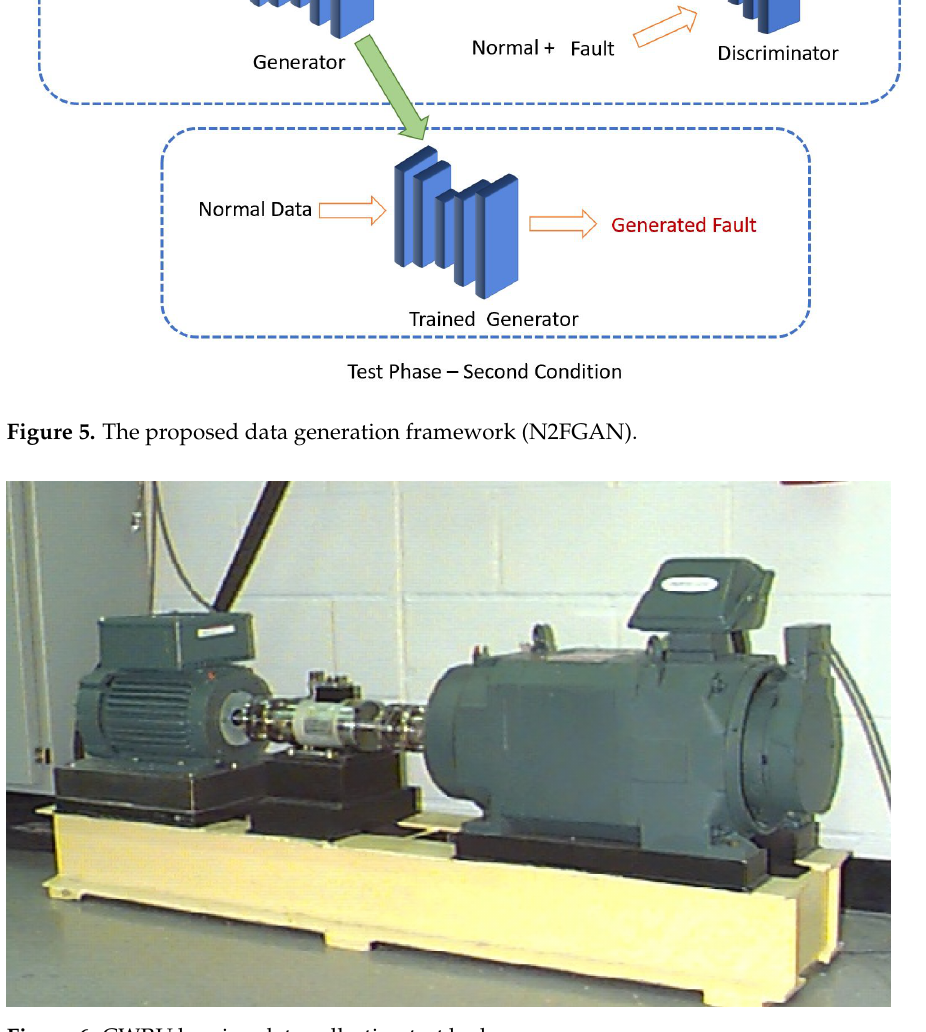
Figure 6. CWRU bearing data collection test